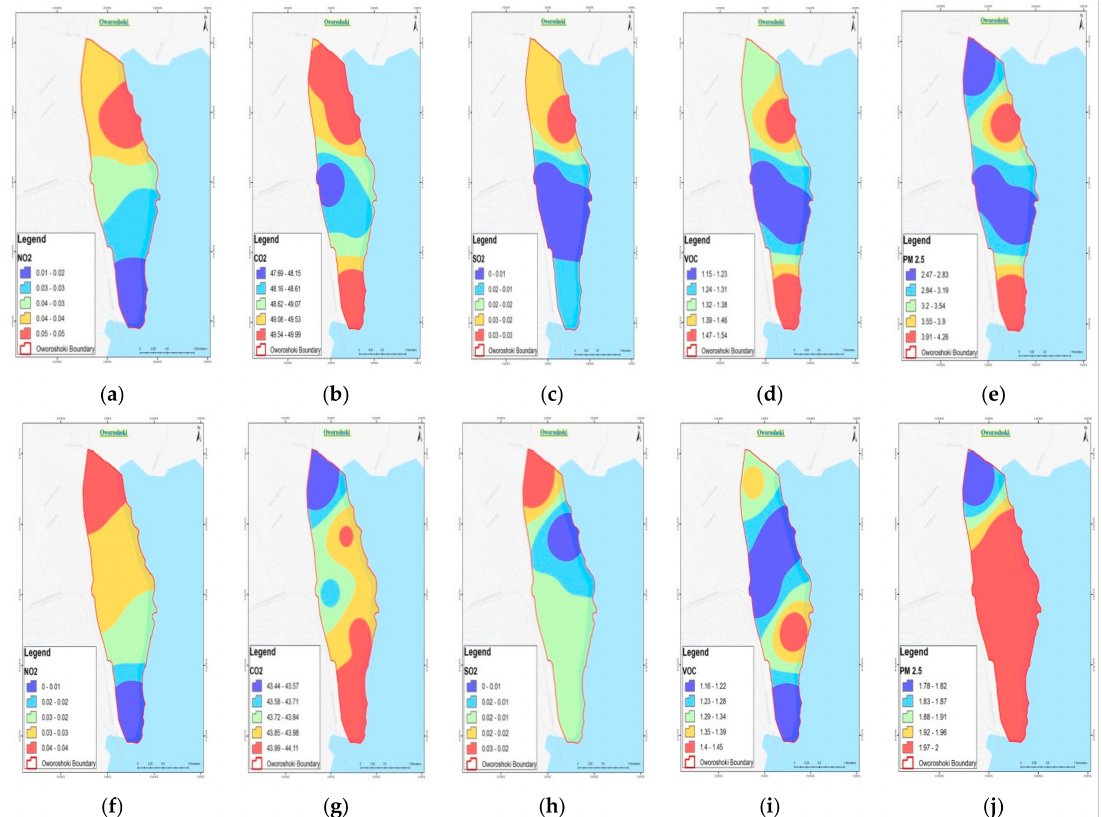
Figure 8. Spatial pattern of air pollutant concentrations from the Oworoshoki slum settlement from the 2018 to 2019 sampling periods for the wet and dry seasons. The dispersal pattern of the pollutants is shown on the map with different colors, and the legend displays the quantity of pollutant released in the ambient environment of the slum. ( a ) NO 2 mg/m 3 Dry; ( b ) CO 2 mg/m 3 Dry; ( c ) SO 2 mg/m 3 Dry; ( d ) VOC mg/m 3 Dry; ( e ) PM 2.5 µ g/m 3 Dry; ( f ) NO 2 mg/m 3 Wet; ( g ) CO 2 mg/m 3 Wet; ( h ) SO 2 mg/m 3 Wet; ( i ) VOC mg/m 3 Wet; ( j ) PM 2.5 µ g/m 3